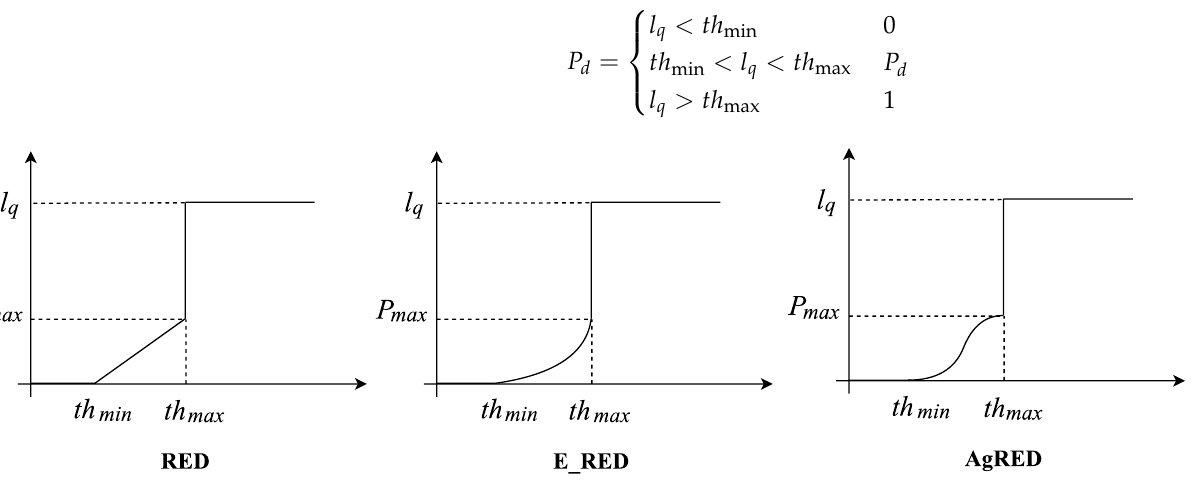
Figure 4. Dropping probability curve comparison between RED, E_RED, and AgRED, the dropping probability is presented on the y -axis, while queue length is shown on the x -axis.